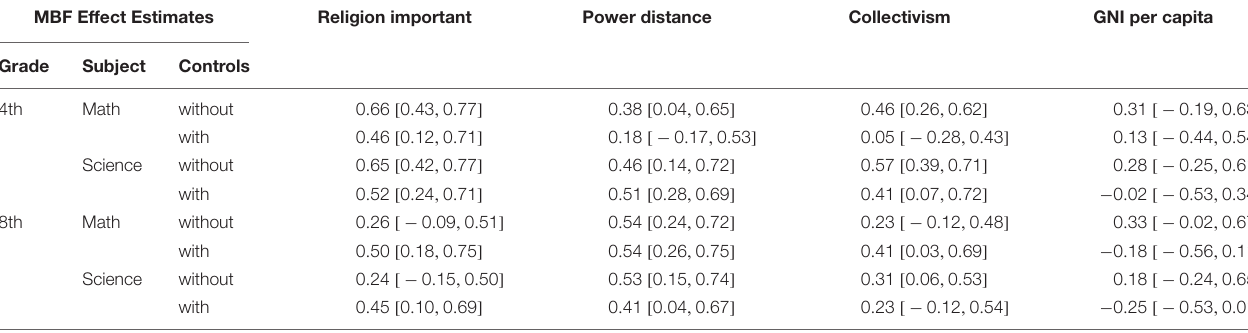
TABLE 5 | Correlations between MBF effect estimates and country measures from other